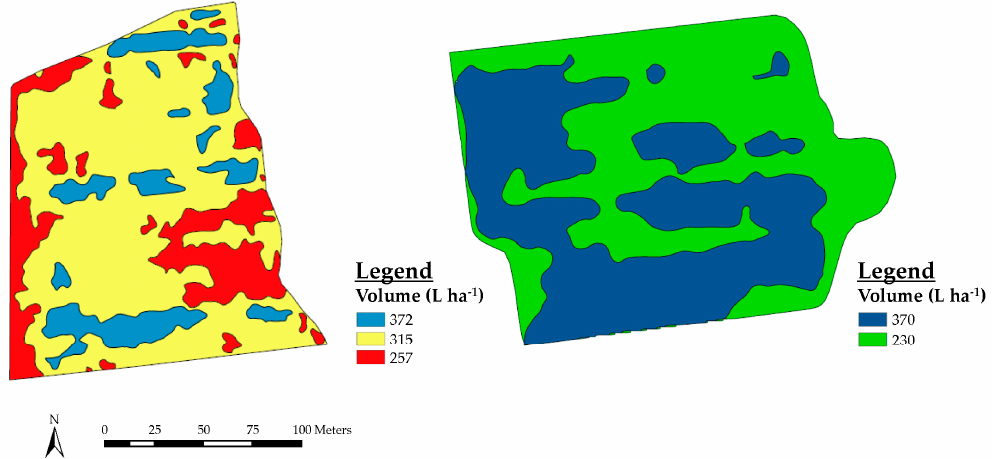
Figure 6. Examples of prescription maps used in the field tests. Left: June 20th of parcel 1 (Chardonnay). Right: July 12th parcel 2 (Merlot).